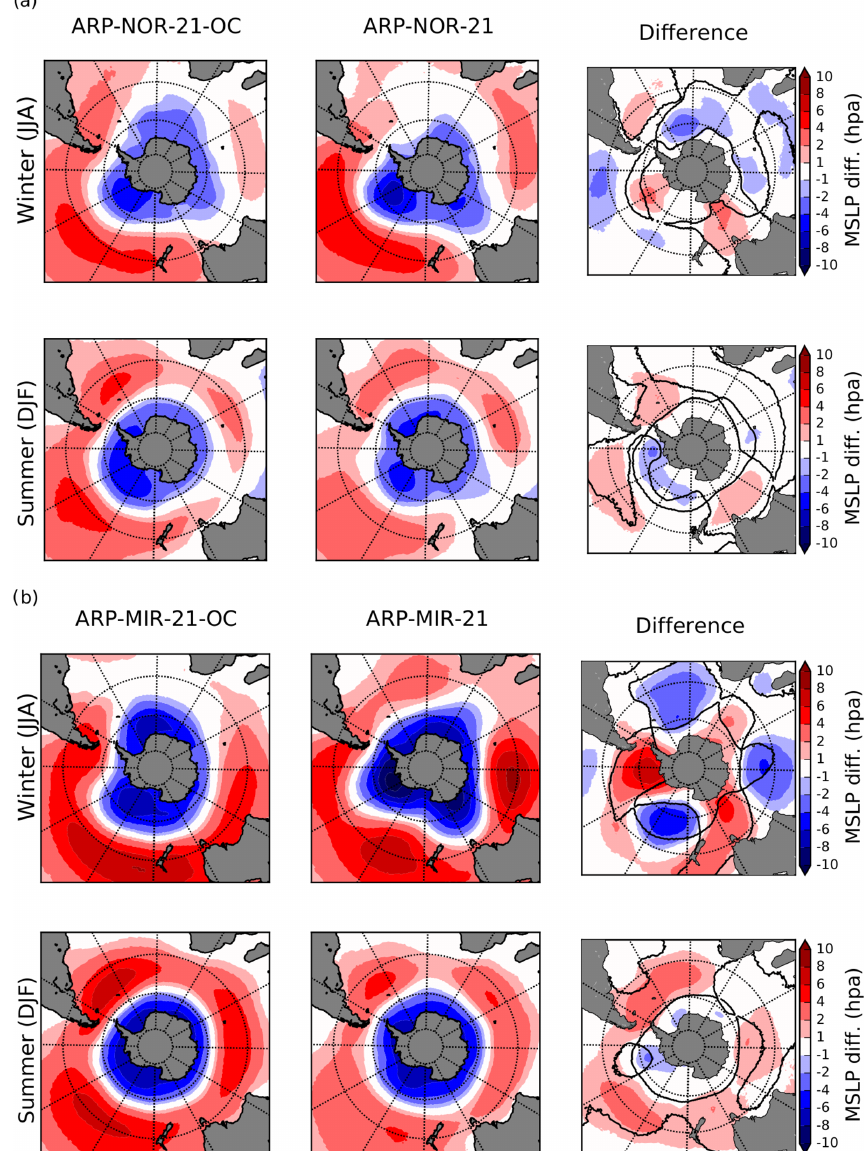
Figure 6. Climate change signal in SLP for ARPEGE RCP8.5 projections with bias-corrected SSCs (left), original SSCs (centre) and difference (right). Climate change signals for winter (JJA) are displayed at the top of the panels and at the bottom for summer (DJF). Results for projections with SSCs from NorESM1-M are presented in the upper part (a) and from MIROC-ESM in the lower part (b) of the figure. Black contour lines represent areas where differences in climate change signal are 50% of the climate change signal in the simulation with non-bias-corrected